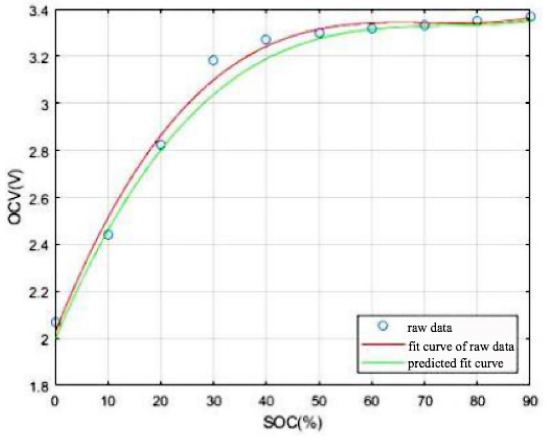
Figure 6. The OCV–SOC curve after the parameter identification.